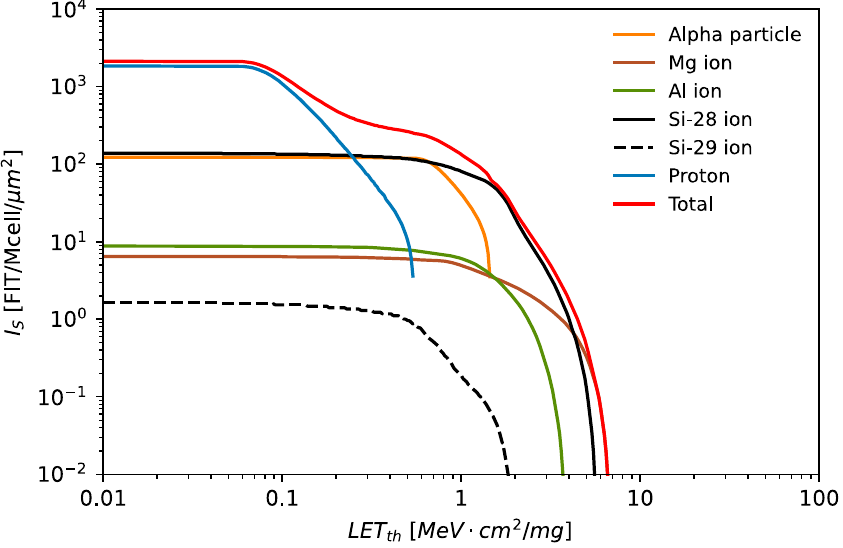
Figure 7. I S function as a function of LET threshold for atmospheric neutrons in the 1–10 MeV energy range.